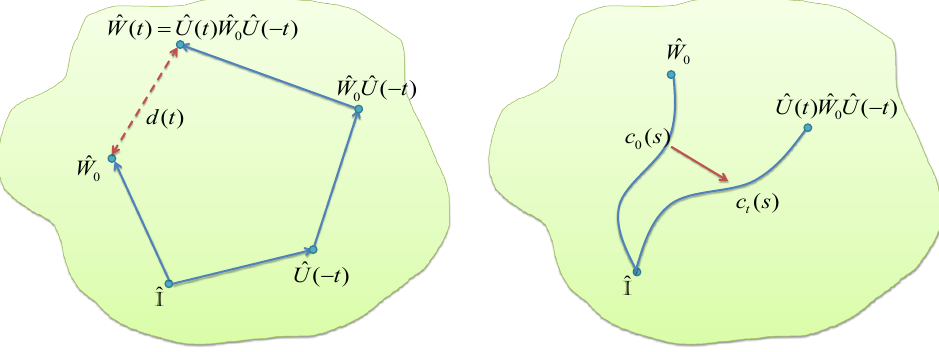
Figure 5 . Left panel: geometric explanation of ^ W ( t ) = ^ U ( t ) ^ W 0 ^ U ( (cid:0) t ) and distance d ( t ) (relative complexity). Right penal: c 0 ( s ) and c t ( s ) are two geodesics connecting from ^ I to ^ W 0 and ^ W ( t ) respectively. It is possible that two geodesics c 0 ( s ) and c t ( s ) have the same length even though ^ W ( t ) 6 = W 0